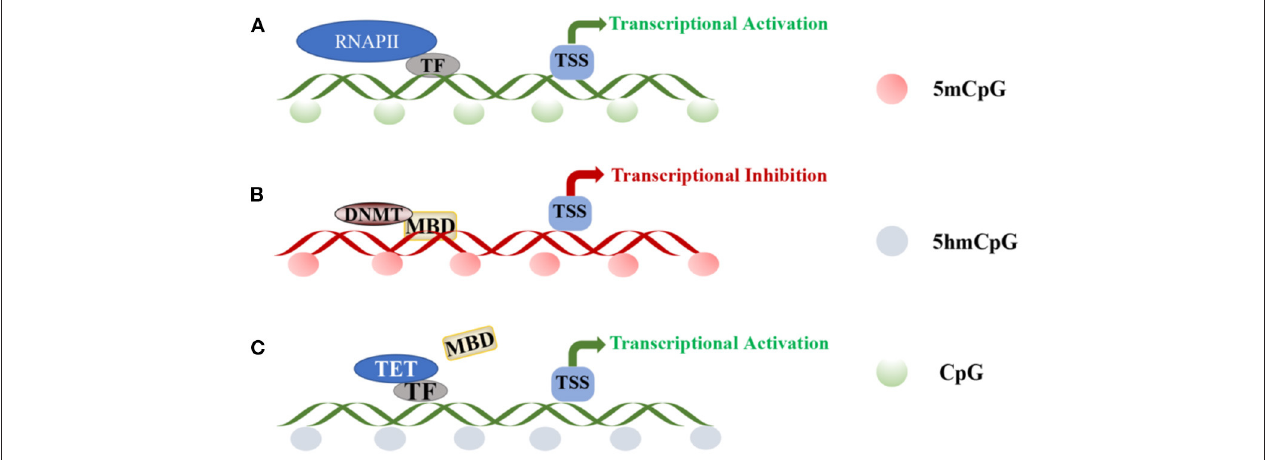
FIGURE 2 | DNA methylation and demethylation: (A) TF and RNAPII bind to the promoter region of the gene, activating transcription at unmethylated promoters. (B) CpG island methylation is mediated by DNA methyltransferases and induces DNA methylation through MBD proteins. (C) Transcription factors recruit TET enzymes to specific sites for regulating local DNA demethylation.TF, transcription factor; RNAPII, RNA polymerase II; TSS, transcriptional start site; DNMT, DNA-methyltransferases; MBD, methyl-CpG-binding domain; TET, ten-eleven